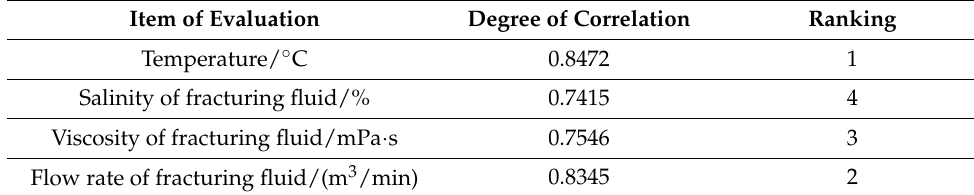
Table 4. Results of correlation degree.